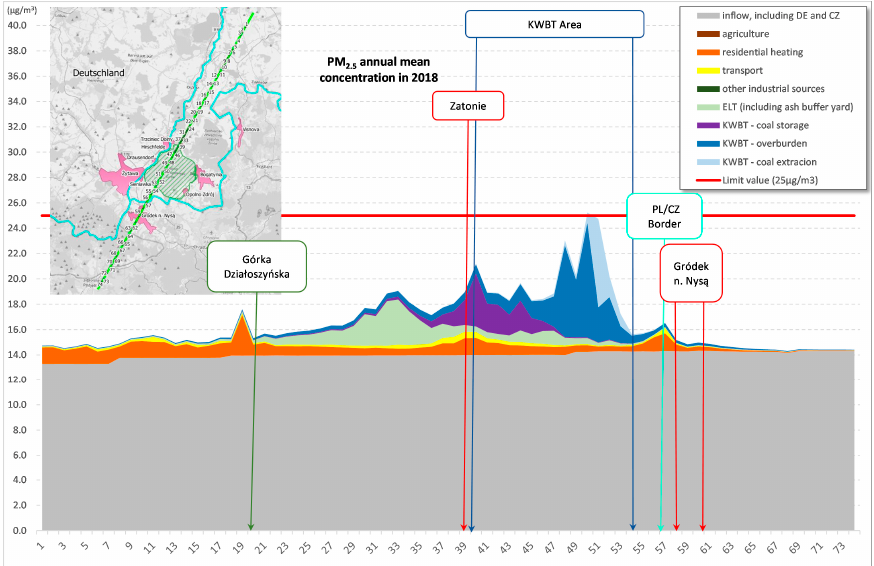
Figure 22. Profile of annual mean concentrations of PM 2.5 between Dzia ł oszyn and Hrádek nad Nisou, considering the shares of individual source groups in 2018 (source: own study).